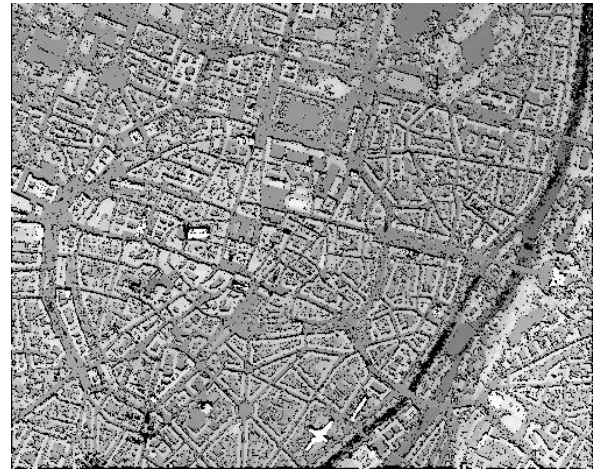
Figure 8. Height map ranging from 500 to 600 m fitting on the first WorldView-2 image, 2500 m × 2000 m The filled DSM, the DTM and nDSM are already shown in fig.